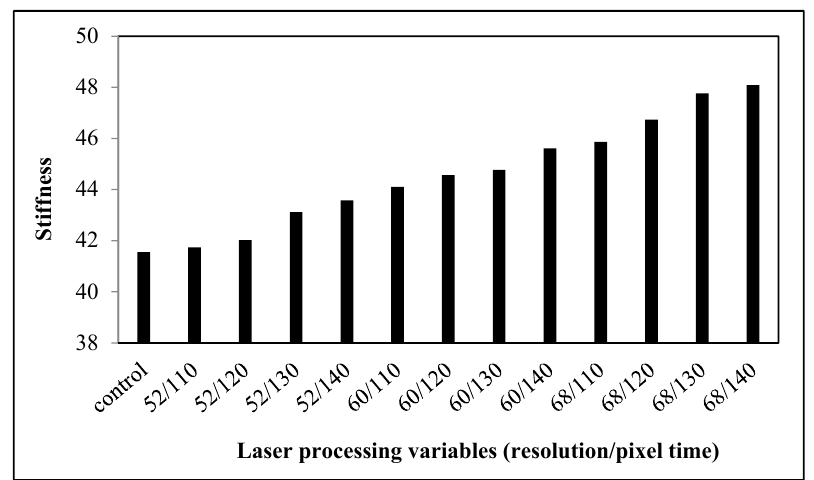
Figure 1. Relationship between the laser processing variables and stiffness of cotton fabric.